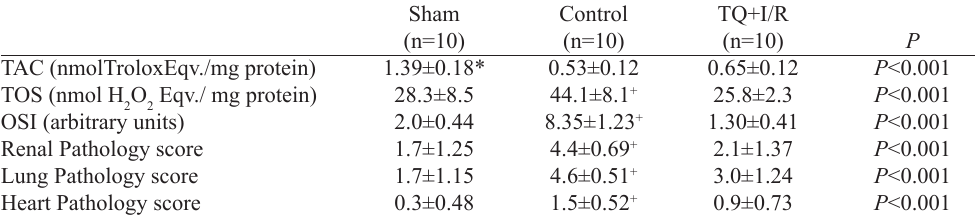
Table 1. Oxidative and antioxidative parameters and histopathological evaluation in Sham, Control and TQ + I/R rats.